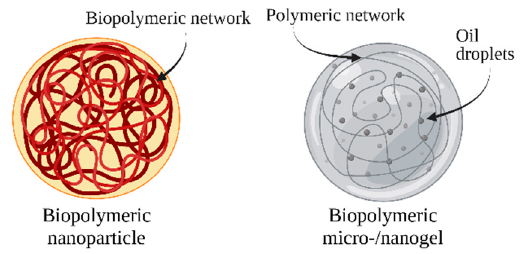
Figure 4. Schematic representation of biopolymeric nanocarriers.